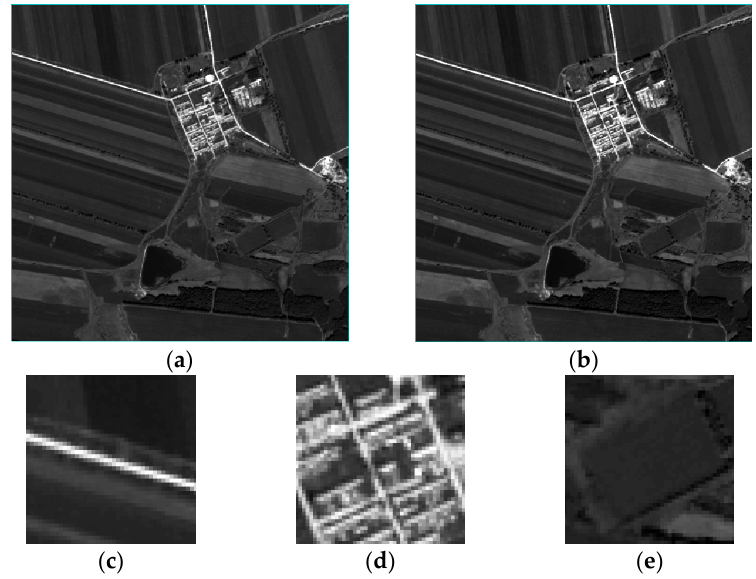
Figure 12. ( a , b ) are the experimental data; ( c ) detail of the road; ( d ) detail of the house; ( e ) detail of the paddy fields.